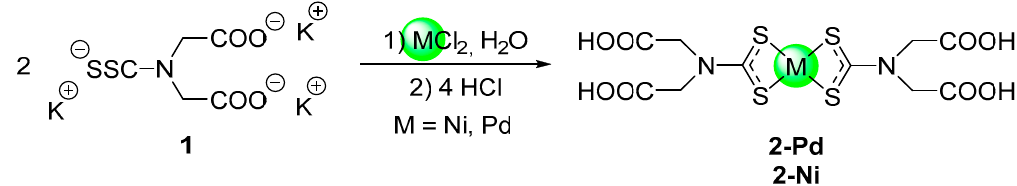
Scheme 2. Preparation of the complexes [M(H 2 L) 2 ] ( 2 ; M = Ni, Pd) from the potassium DTCC salt 1 Table 1. Selected characterization data for [M(H 2 L) 2 ] ( 2 ), Zn 2 [M(L) 2 ] ( 4 and 5 ; M = Ni, Pd, Pt). Compound T Dec. /°C